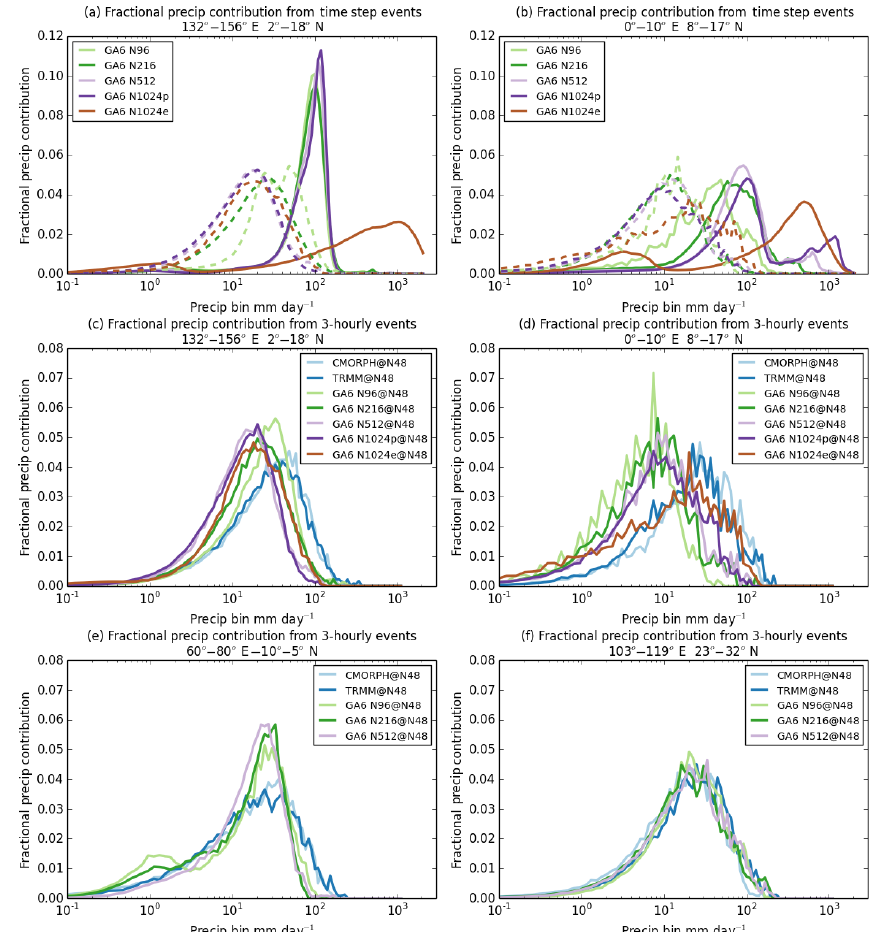
Figure 9. (a, b) Precipitation spectra averaged over different regions for the five model configurations. Solid lines show spectra at native resolution and time step while dashed lines show the spectra from each configuration when precipitation data are averaged to the N48 grid: (a) “WP” domain; (b) “WA” domain. (c–f) Precipitation spectra averaged to the N48 grid and 3h timescale, for (c) “WP” domain, (d) “WA” domain, (e) equatorial Indian Ocean (60–80 ◦ E, 10 ◦ S–5 ◦ N), (f) southern China (103–119 ◦ E, 23–32 ◦ N). N1024 data are not available for the latter two regions. Also included in each panel are results from the CMORPH and TRMM satellite-based rainfall analyses averaged to the same spatial and temporal